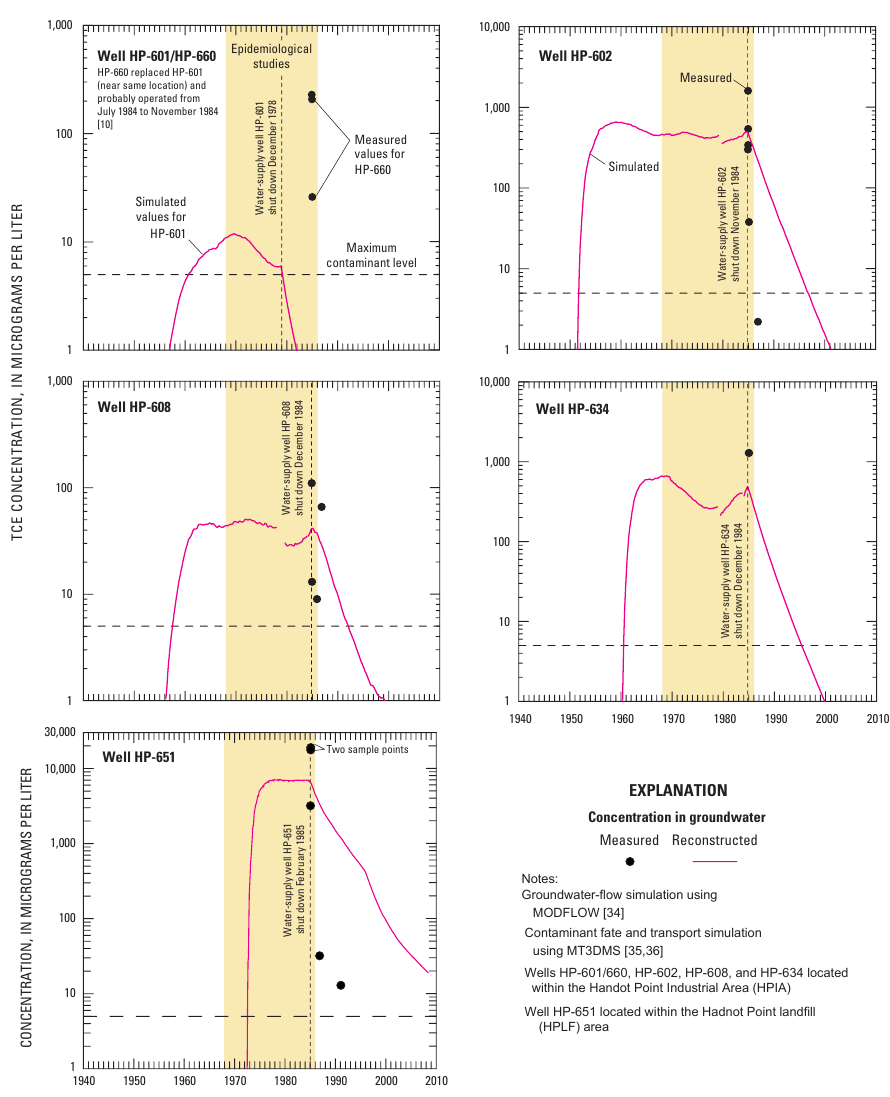
Figure 3. Reconstructed (simulated) and measured concentrations of trichloroethylene (TCE) at selected Figure 3. Maslia et al. 2016 water-supply wells within the Hadnot Point Industrial Area and the Hadnot Point landfill area at U.S. Marine Corps Base Camp Lejeune, North Carolina (modified from